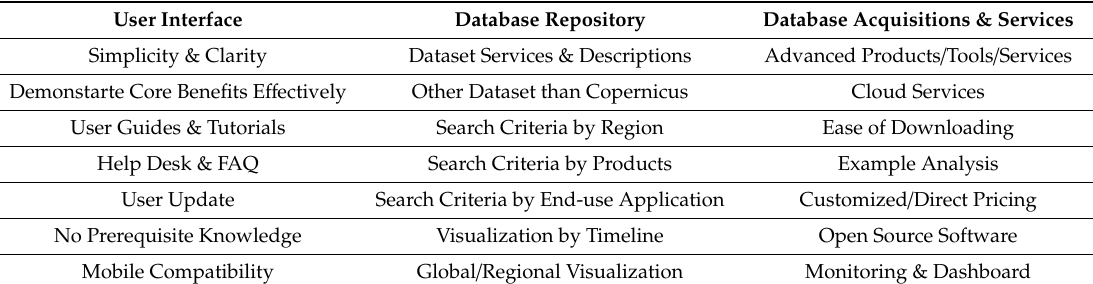
Table 2. Criterias for lowering barriers of EO newcomers on data access